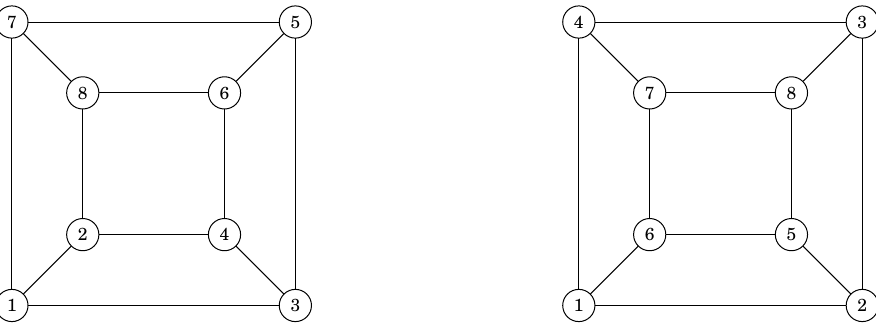
Figure 7: Strongly multiplicative and strongly quotient